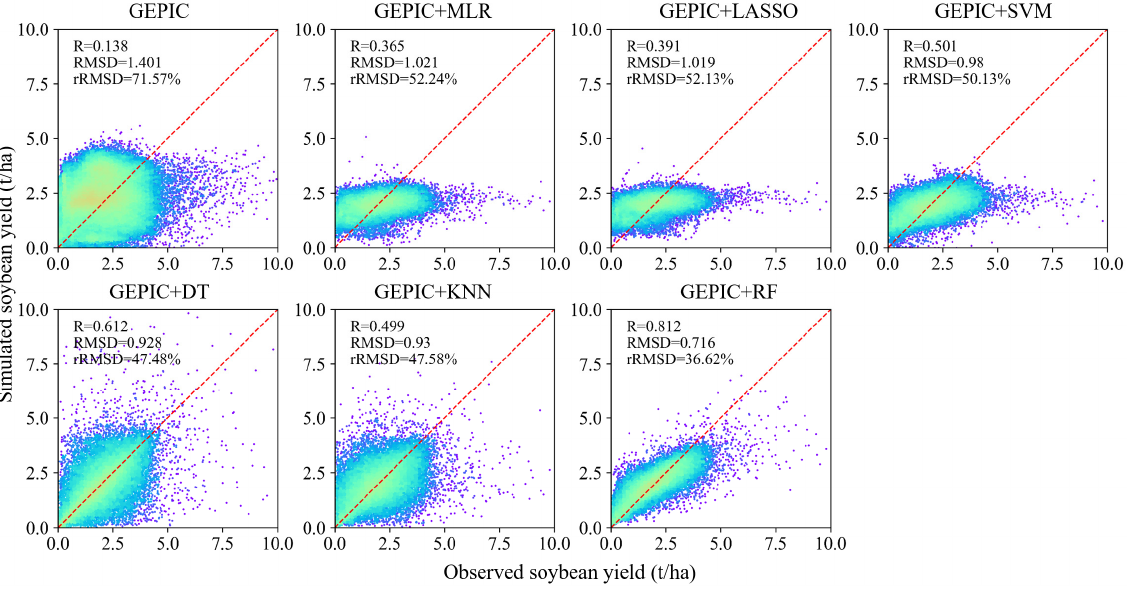
Figure 2. Simulated soybean yield comparisons between GEPIC model and six hybrid models during the historic period from 2001 to 2005 around the globe.